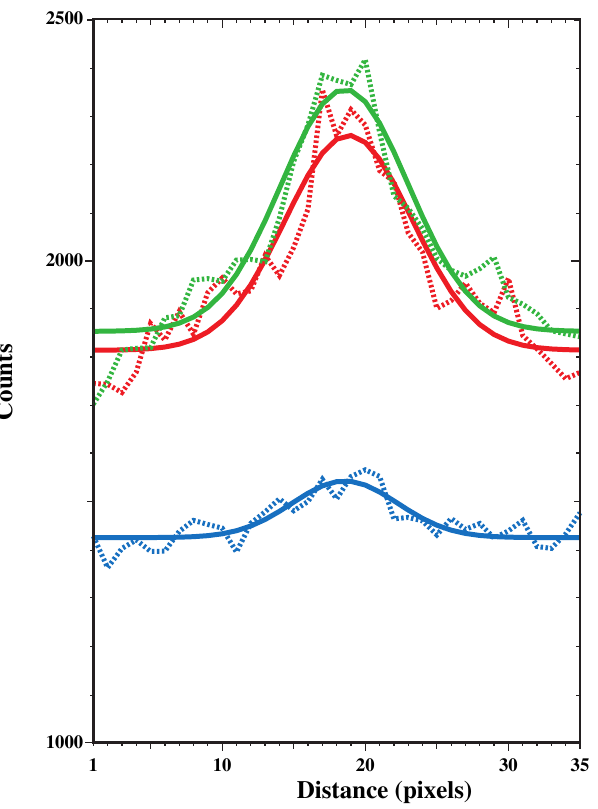
Fig. 7. The arc brightness curves (dashed lines) along the 1km cross-section line in the lower right image of Fig. 5 for green, red and blue colour separately (24 March 2007, at 08:18:48UT). The solid lines are the corresponding Gaussian fits to the brightness pro- files. The FWHMs are 1.0 (R), 1.0 (G) and 0.9km (B).